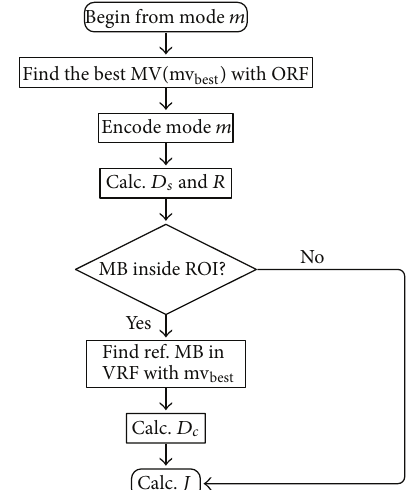
Figure 5: The proposed RD cost calculation process for a mac-